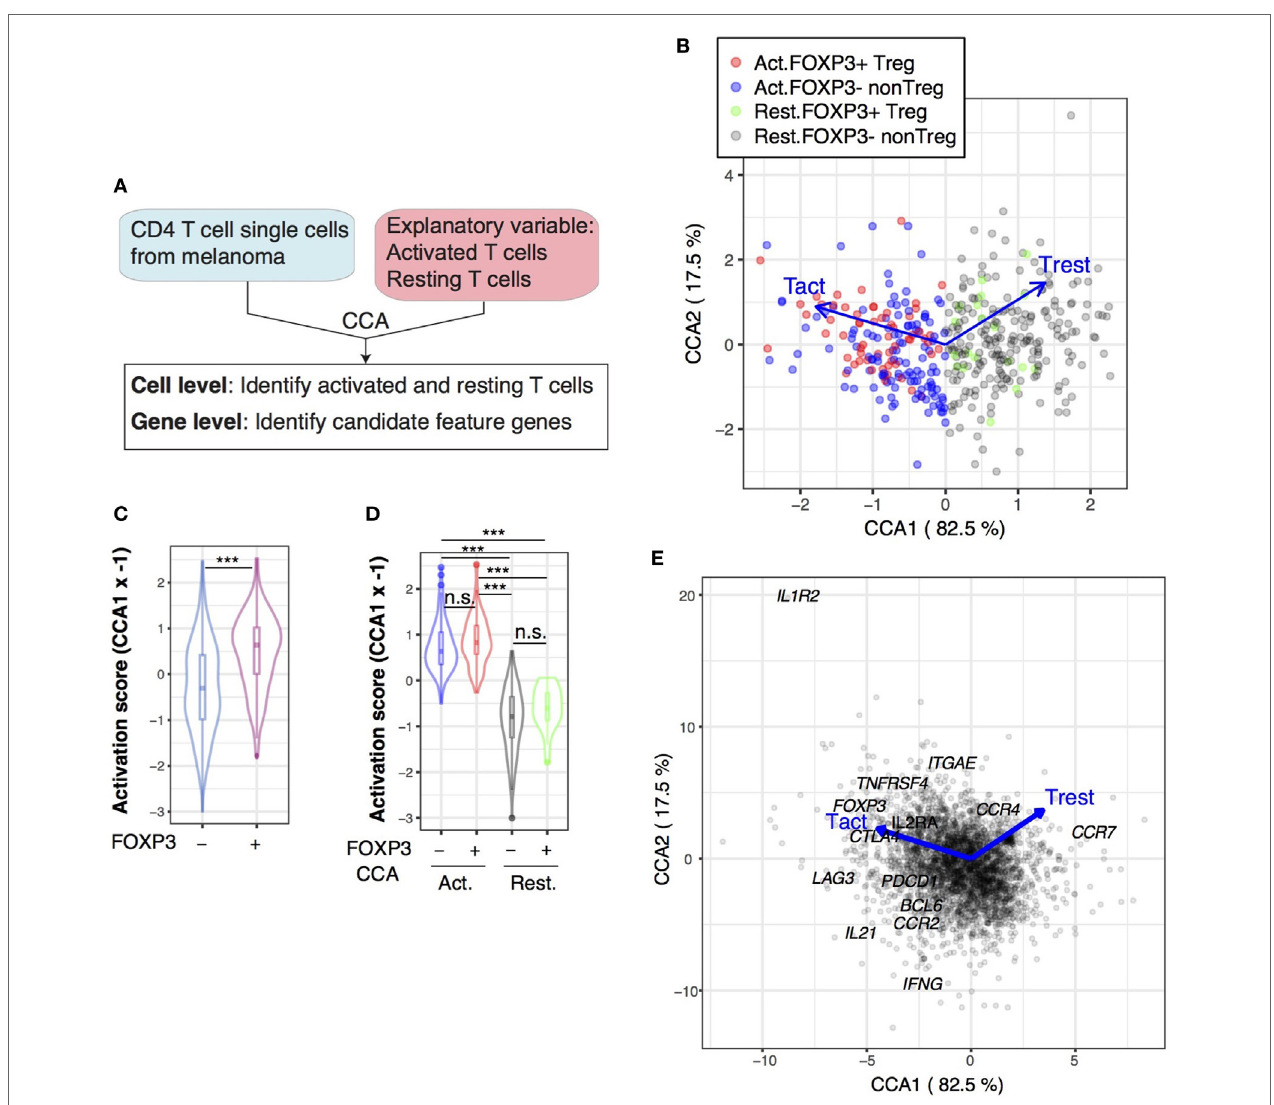
FigUre 8 | Single-cell canonical correspondence analysis (CCA) of melanoma-infiltrating T cells determines the activation status of individual T cells and identifies a putative T follicular helper-like process. (a) Schematic representation of CCA of CD4 + T cell single-cell transcriptomes analyzed by two explanatory variables: activated naïve T cells (Tact) and resting naïve T cells (Trest). (B) CCA biplot showing the relationships between Treg and non-Treg T cells (sample scores) and the explanatory variables (Tact and Trest). Axis 1 represents the difference between Tact and Trest, and thus, activated T cells and resting T cells were defined by the CCA Axis 1 score, and these cells were further classified into Treg and non-Treg by their FOXP3 expression (see legend). Percentage indicates that of the variance (inertia) accounted for by the axis. (c) Violin plot showing the CCA activation scores (Axis 1 score × − 1) of FOXP3 − and FOXP3 + cell groups. Asterisk indicates statistical significance by Mann–Whitney test. (D) Violin plot showing the CCA activation scores of activated (Act.) and resting (Rest.) FOXP3 − and FOXP3 + cell groups. Asterisks indicate the values of post hoc Dunn’s test following a Kruskal–Wallis test. *** p < 0.005. (e) Gene biplot of the CCA solution in (B) showing the relationships between genes (gray circles) and the Tact and Trest explanatory variables (blue arrows). Genes are shown by gray circles, and well-known genes that are key for T cell activation processes are